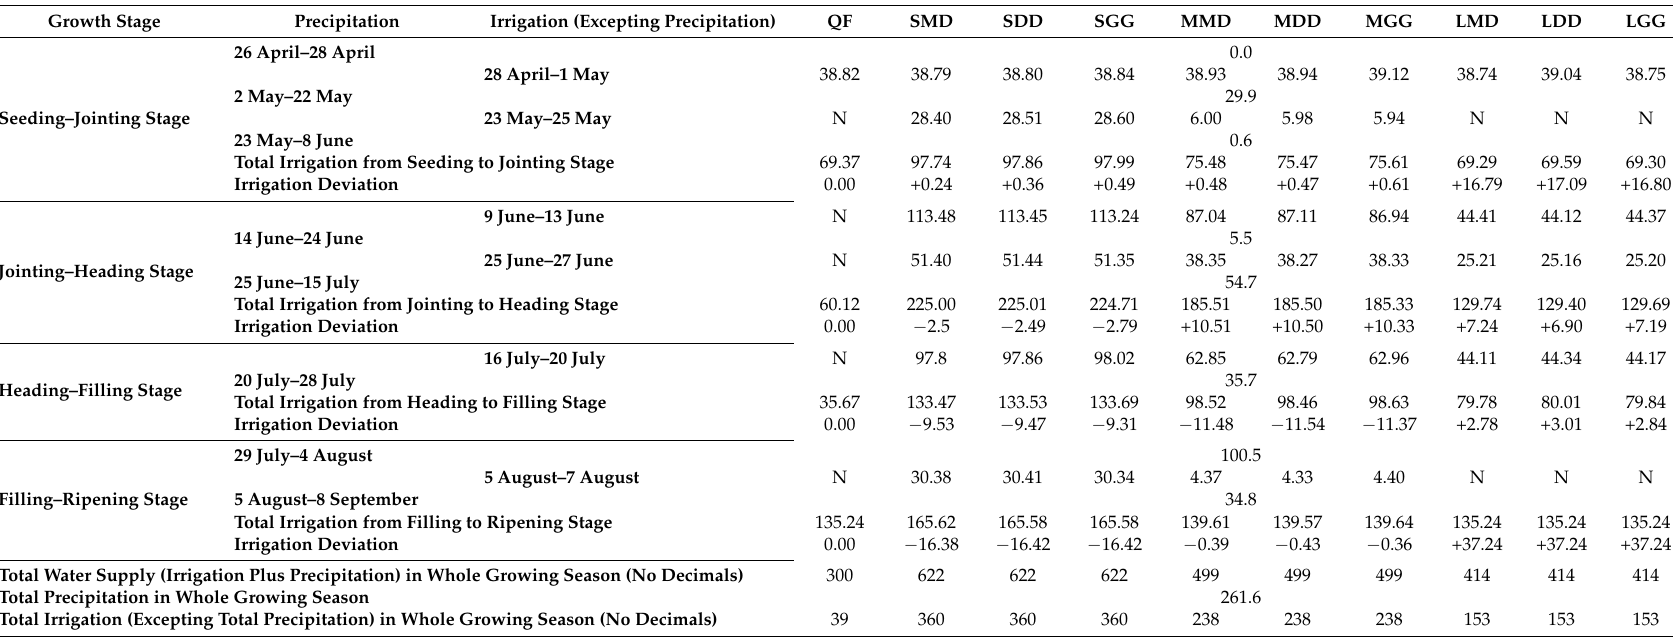
Table 3. The irrigation regimes across the growing season (April–September